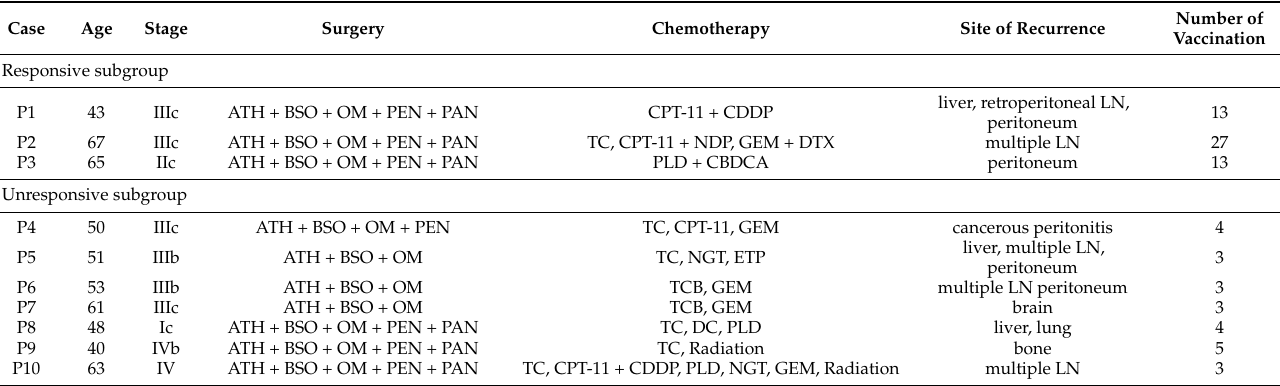
Table 2. Characteristics of patients in